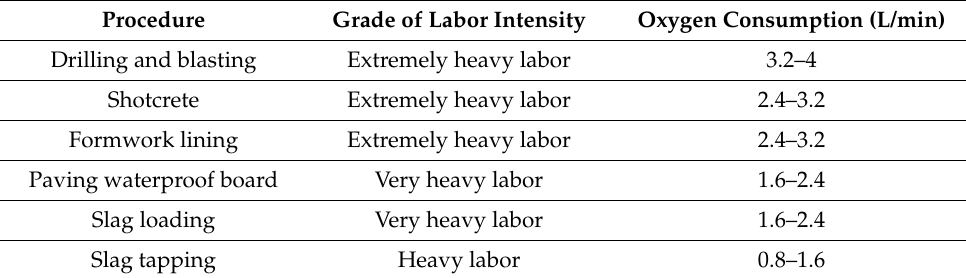
Table 8. Grade of labor intensity and oxygen consumption at the altitude of 4000 m.